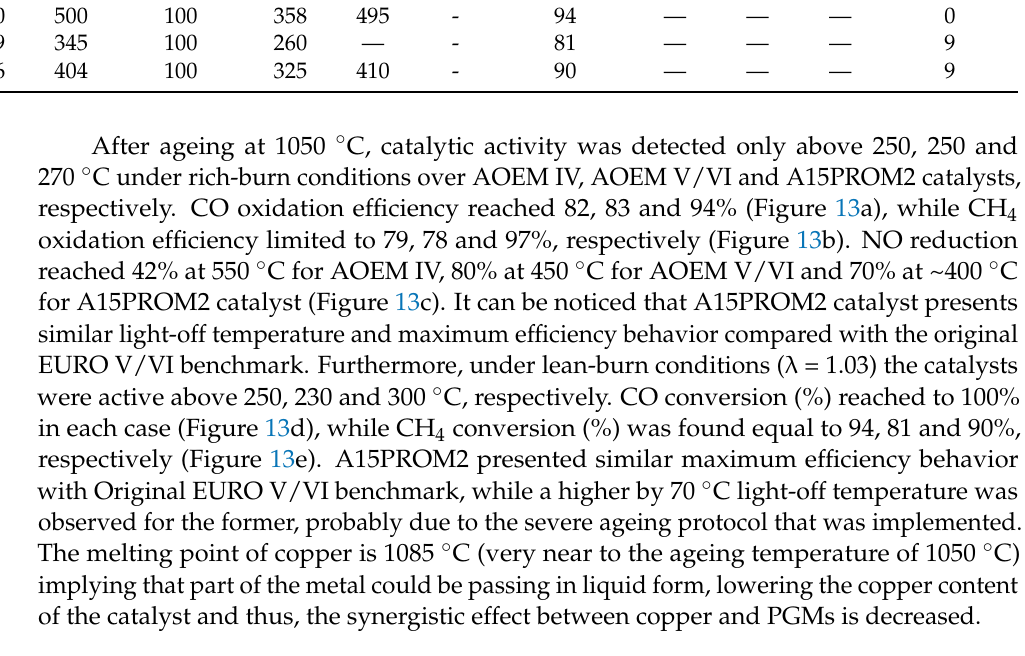
Table 10. Comparison of aged tested catalysts AOEM IV, AOEM V/VI and 15PROM2 under lean-burn conditions ( λ = 1.03).